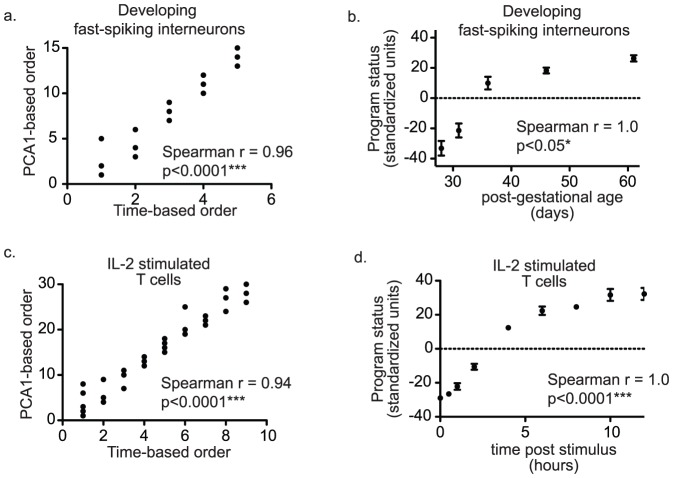
The first principal component (PCA1) measures gene expression program status.Principal components analysis was performed on time course gene expression profiling data. The first principal component score (PCA1) for each transcriptome was used as a measure of program status. Transcriptomes were sorted by PCA1 and their PCA1-based order (y-axis) was compared to their biological time-based order. Panels (2a & 2c) show that PCA1-based and time-based orders are closely related (Spearman r>.94, p<0.0001 for both examples). In panels (2b & 2d), PCA1 is plotted against time to show how program status measures help to visualize gene expression program progression in developing fast-spiking interneurons and in T cells stimulated with interleukin 2 (IL-2).